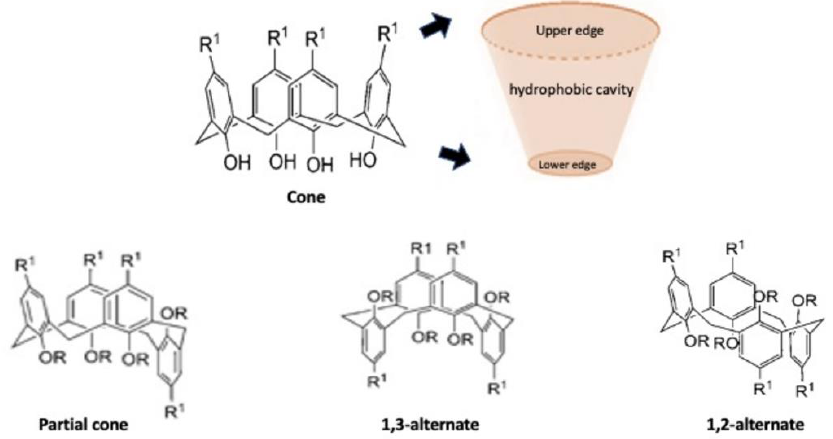
Figure 1. Schematic representation of functionalized structures of calixarene.